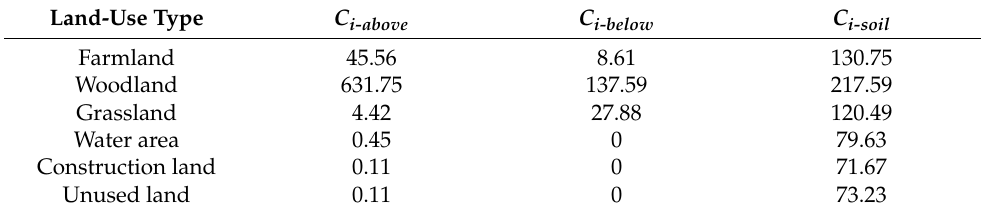
Table 1. Carbon density of different land-use types (t/hm 2